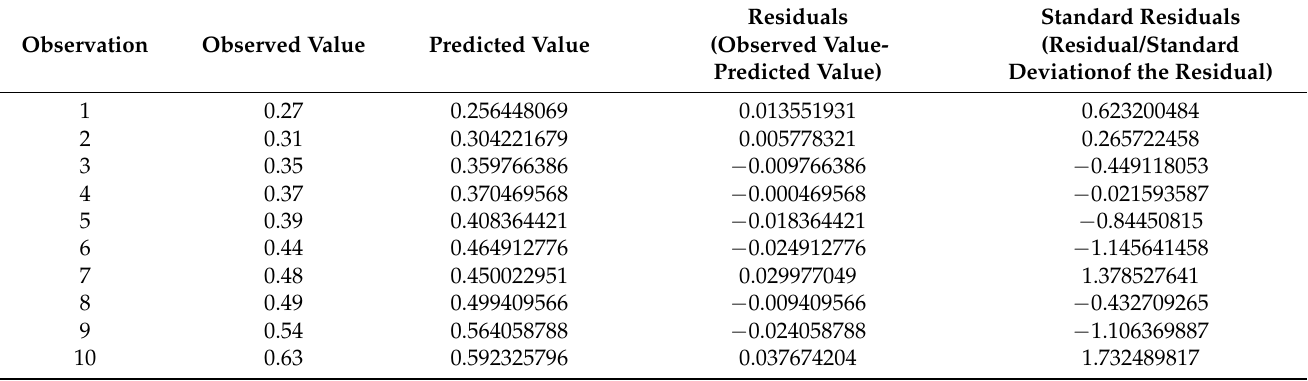
Table 7. Residuals of the